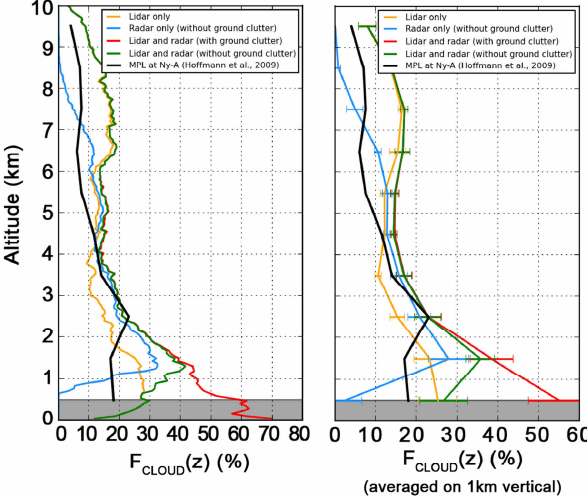
Figure 2. Vertical profiles of cloud occurrences over the Ny- Ålesund station during March and April 2007. The black line refers to ground-based lidar observations at 1km vertical resolution (Hoffmann et al., 2009) and coloured lines refer to a DARDAR product according to different configurations and settings. DARDAR retrievals have a vertical resolution of 60m on the left panel and 1 km on the right panel.